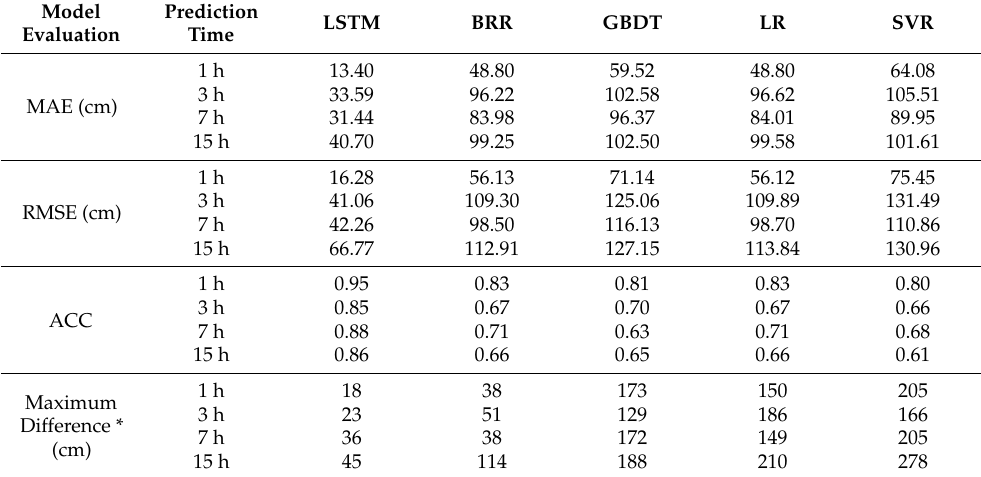
Table 2. Model evaluation of testing set for different models with four prediction times. Model